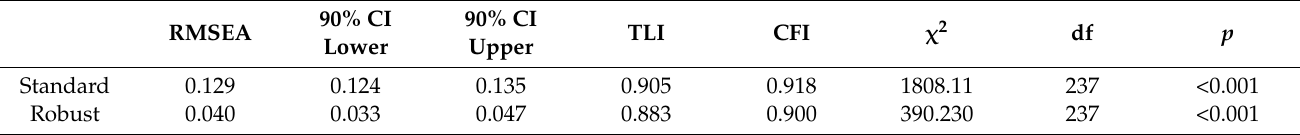
Table 7. Model fit statistics for CFA using standard and robust modelling.